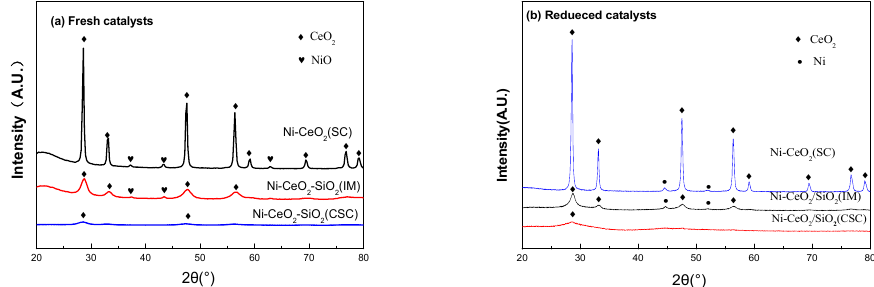
Figure 2. X-ray diffraction (XRD) patterns of ( a ) fresh and ( b ) reduced catalysts.